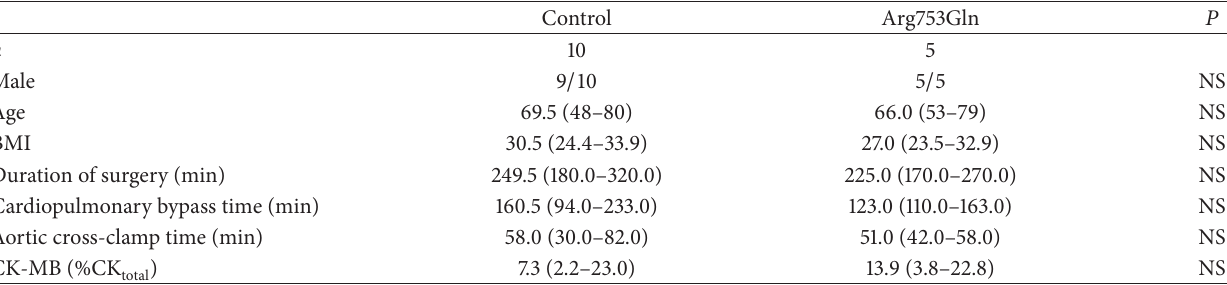
Table 1: Patient demographics.